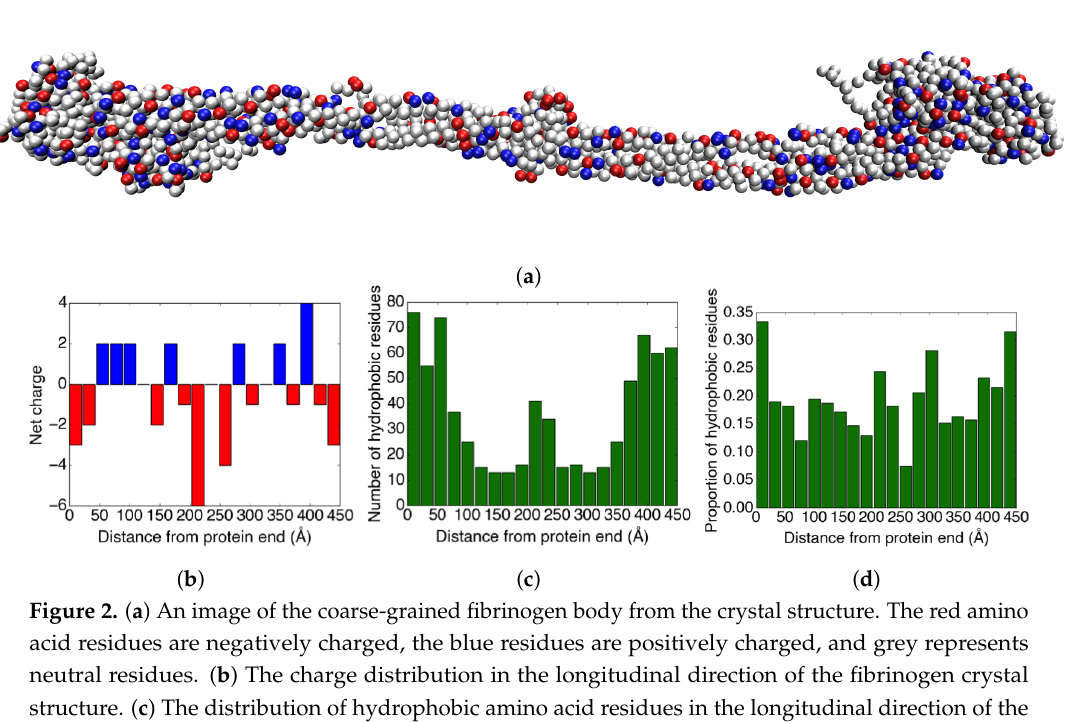
Figure 2. ( a ) An image of the coarse-grained fibrinogen body from the crystal structure. The red amino acid residues are negatively charged, the blue residues are positively charged, and grey represents neutral residues. ( b ) The charge distribution in the longitudinal direction of the fibrinogen crystal structure. ( c ) The distribution of hydrophobic amino acid residues in the longitudinal direction of the fibrinogen crystal structure. ( d ) The proportion of the ≥ 20% solvent-accessible amino acid residues that are hydrophobic for each